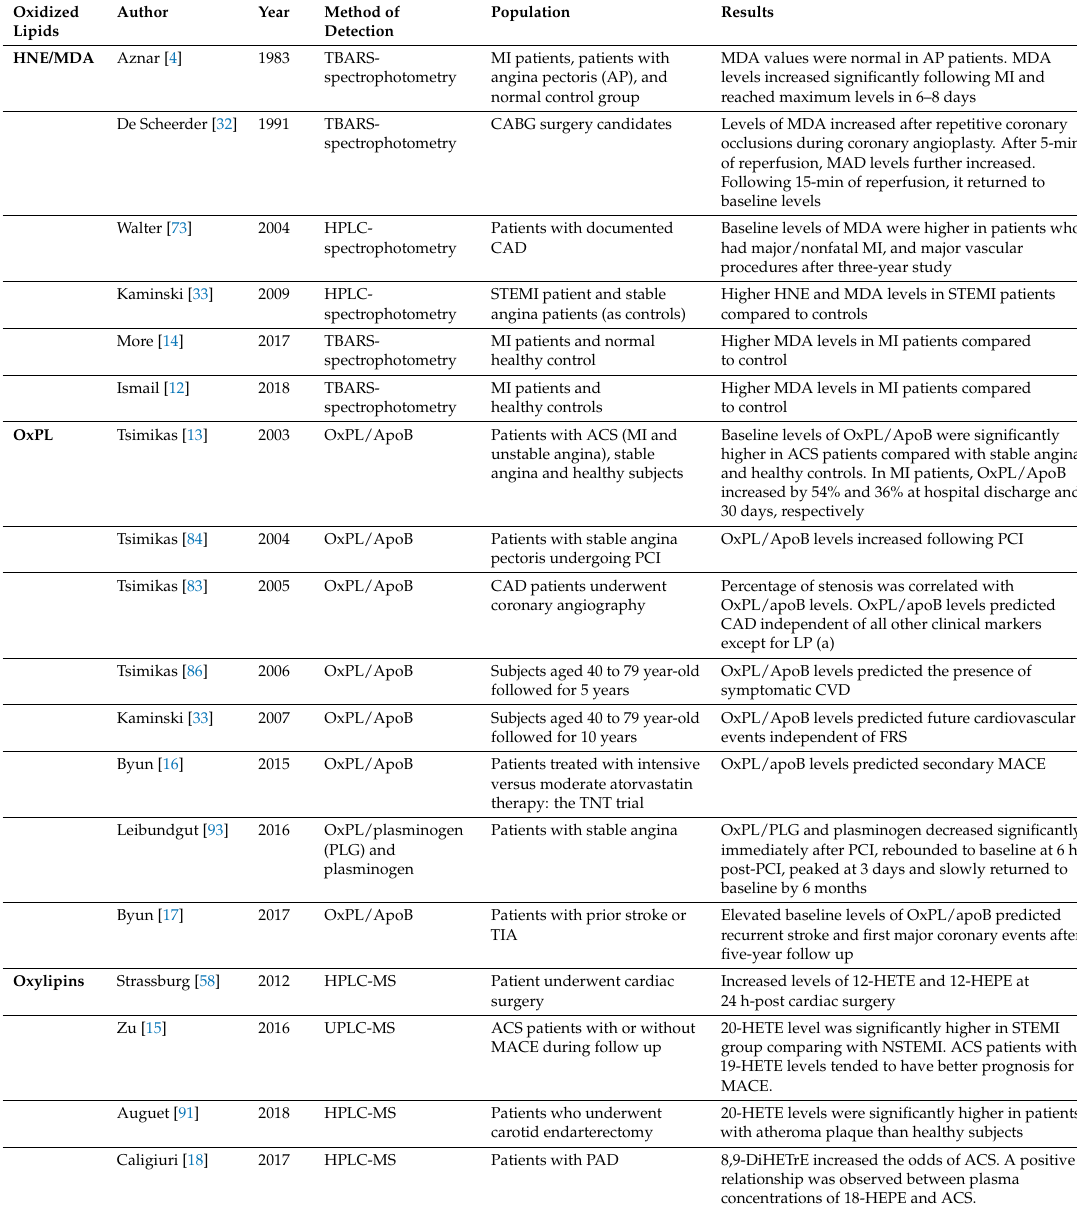
Table 1. Clinical studies that have assessed bioactive lipids in ACS patients